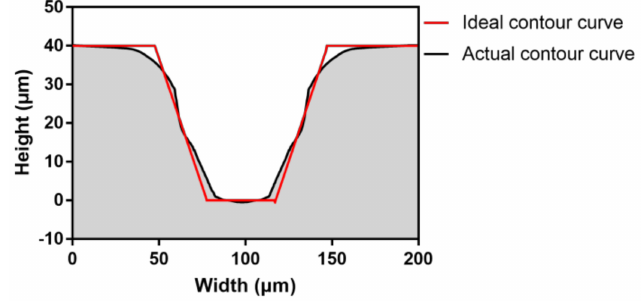
Figure 6. The ideal and actual contour curves of the